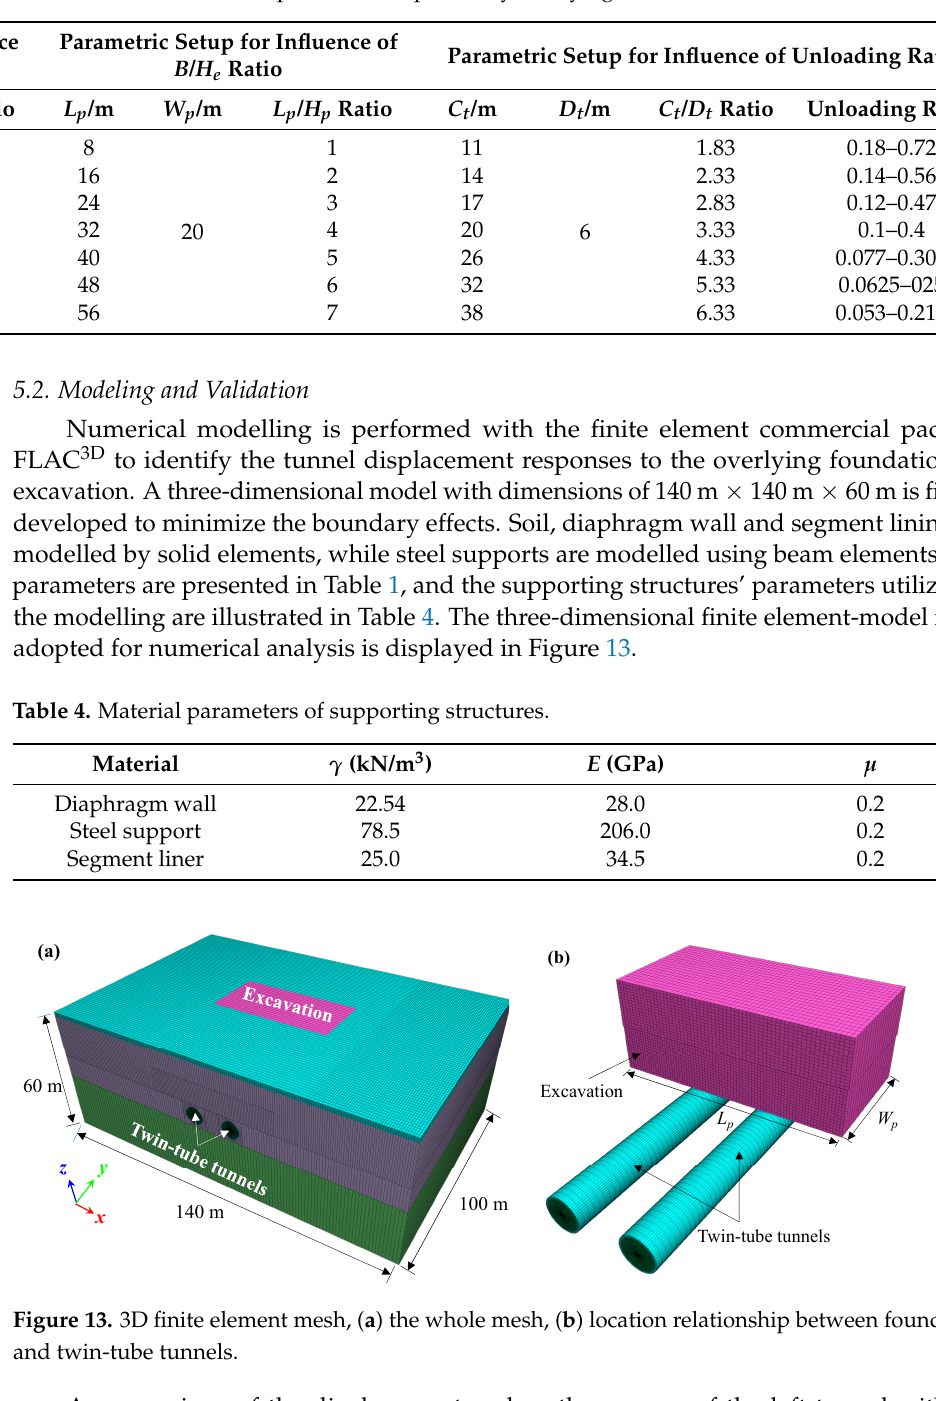
Figure 14. Comparison of tunnel displacements between numerical simulation and experimental test. 0